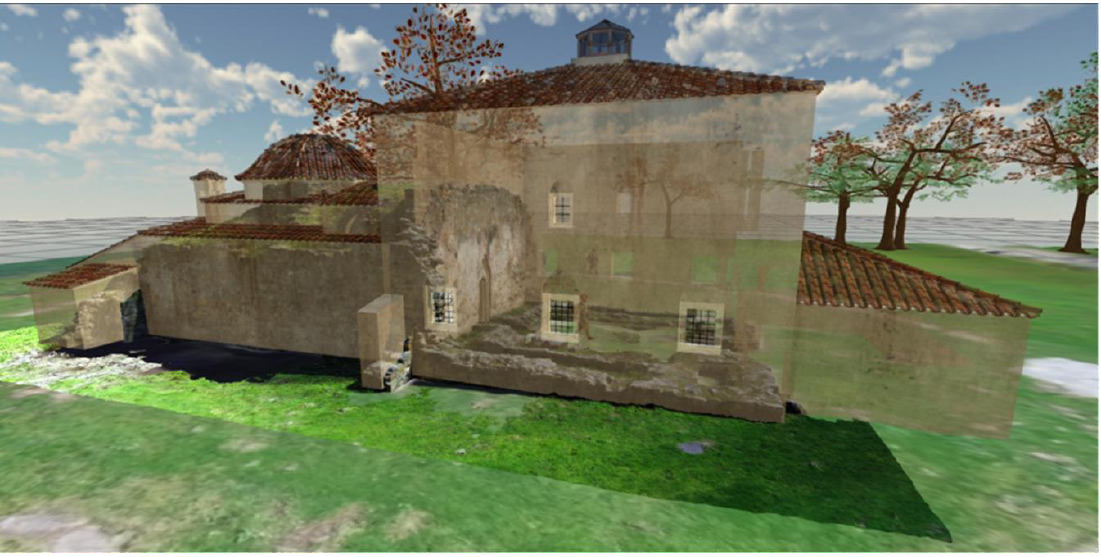
Figure 10. Interacting with real (mixed) and virtual objects via the touch screen.